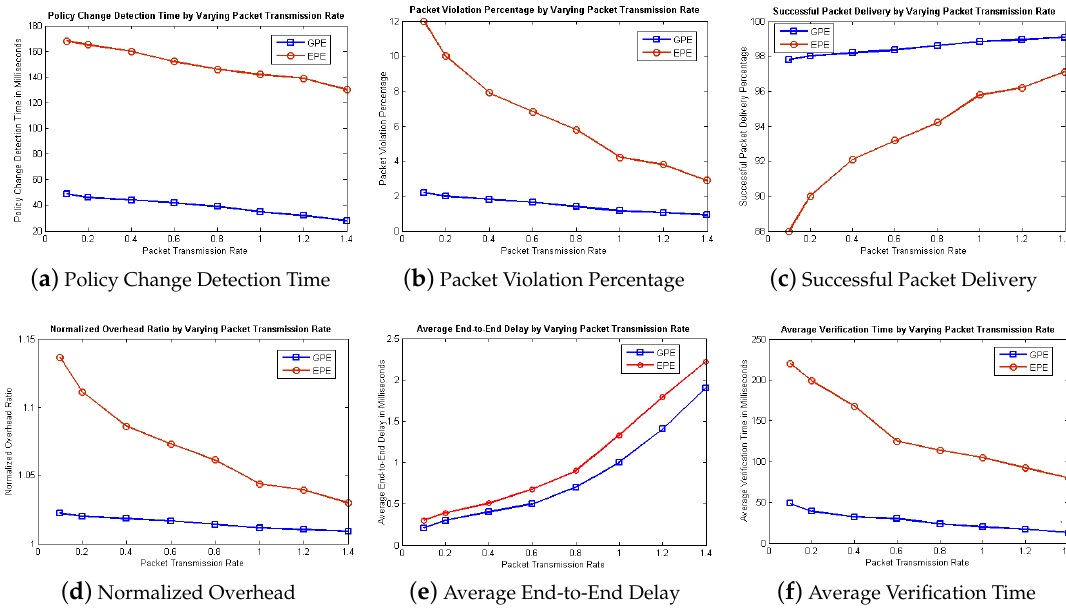
Figure 6. Simulation Results by Varying Packet Transmission